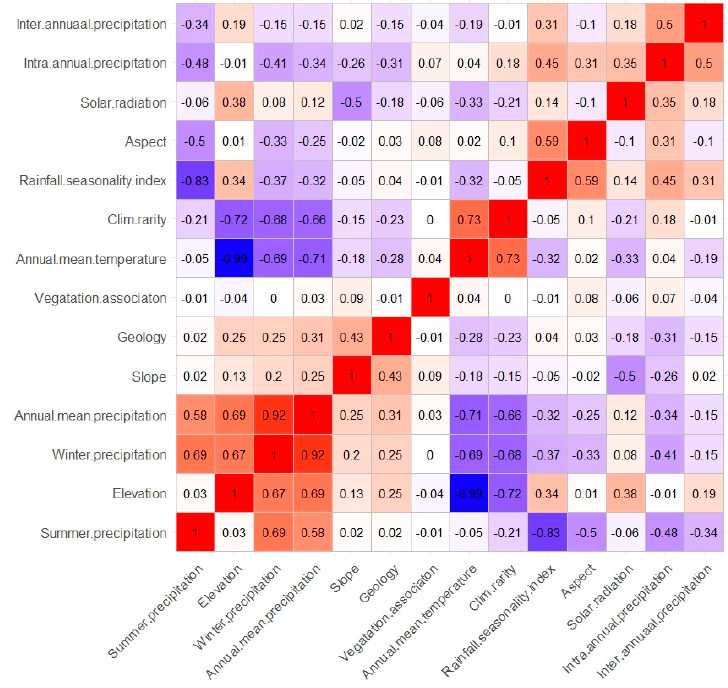
Figure A2. Pearson correlation coefficients of environmental raster used in ecological niche modelling (ENM).